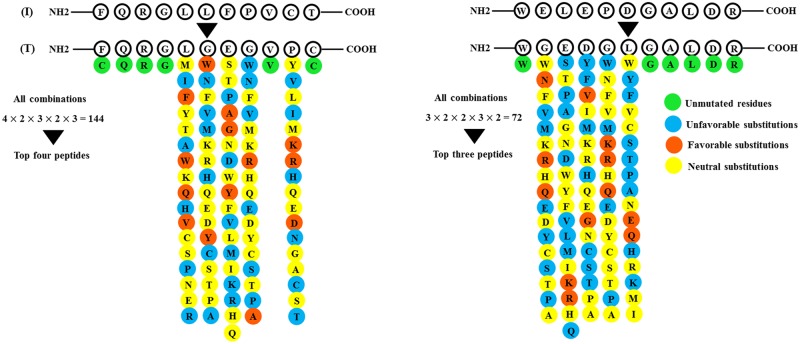
A schematic representation of BoxI (Left) and BoxII (Right) peptide optimization.The initial peptides (I) were tolerated (T) using Backrub and sequence tolerance protocols conducted by Rosetta package. Each position of peptide was substituted with other residues (substitutions with BLOSUM62 score -4 were omitted to avoid deleterious substitutions). The blue, orange and yellow colors indicate unfavorable (ΔGinteraction of resulted peptide > ΔGinteraction of input peptide), favorable (ΔGinteraction of resulted peptide < ΔGinteraction of input peptide) and neutral substitutions (ΔGinteraction of resulted peptide ≊ ΔGinteraction of input peptide), respectively, and the green color represents non-mutated residues. Substitutions that caused a <100 change in the value of interaction weighted score (calculated by ClusPro) were considered as neutral. All possible combinations of favorable substitutions were generated and the best peptides were selected among them.